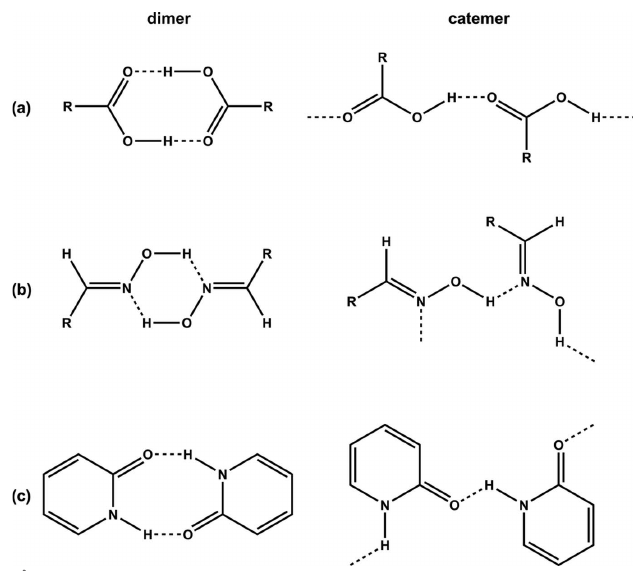
Figure 1 Hydrogen-bonded dimers and catemers of ( a ) carboxylic acids, ( b ) oximes and ( c ) 2(1 H )-pyridinone.